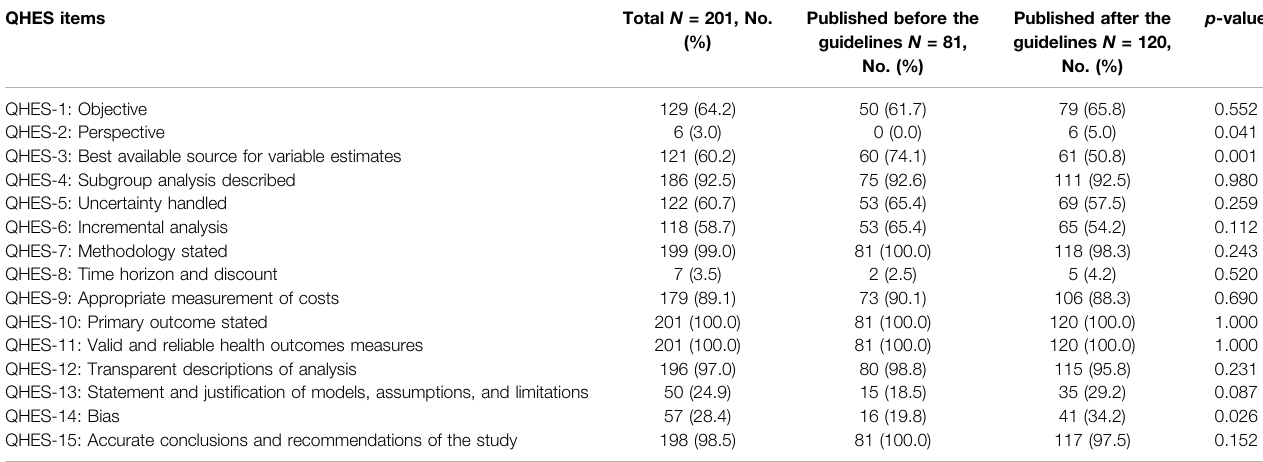
TABLE 2 | Comparison of QHES of the Included Studies before and after the Publication of the China PE guideline. QHES items Total N = 201, No.